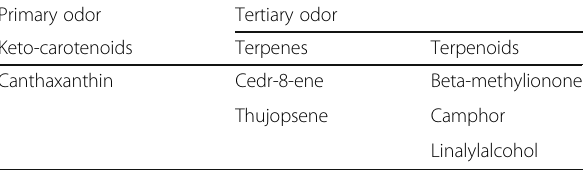
Table 4 VOCs related to “ primary odor ” and “ tertiary odor